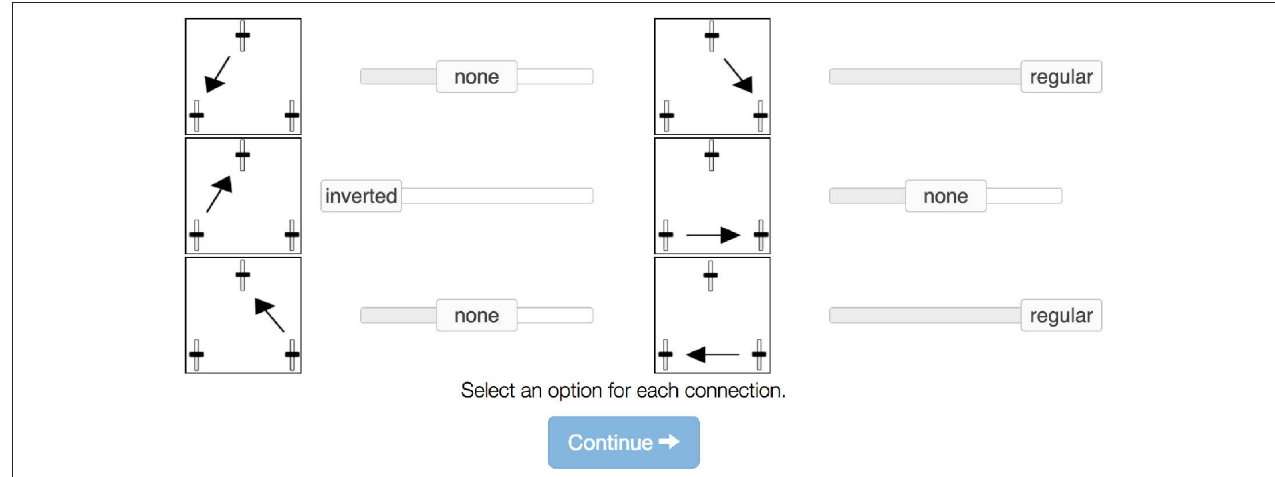
FIGURE 6 | Judgment options for participants. Participants were presented with a ternary choice between “inverted,” “none,” and “regular”.